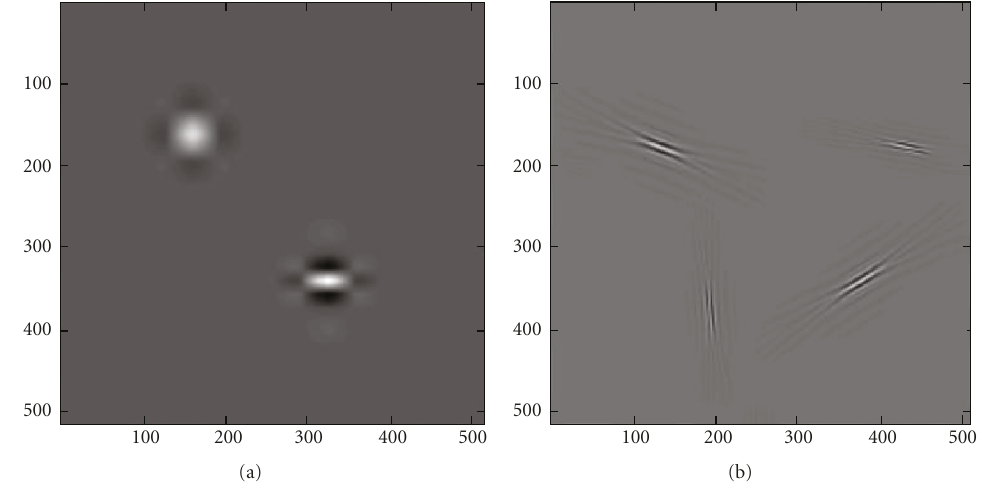
Figure 3: The elements of wavelets (a) and curvelets on various scales, directions and translations in the spatial domain (b).